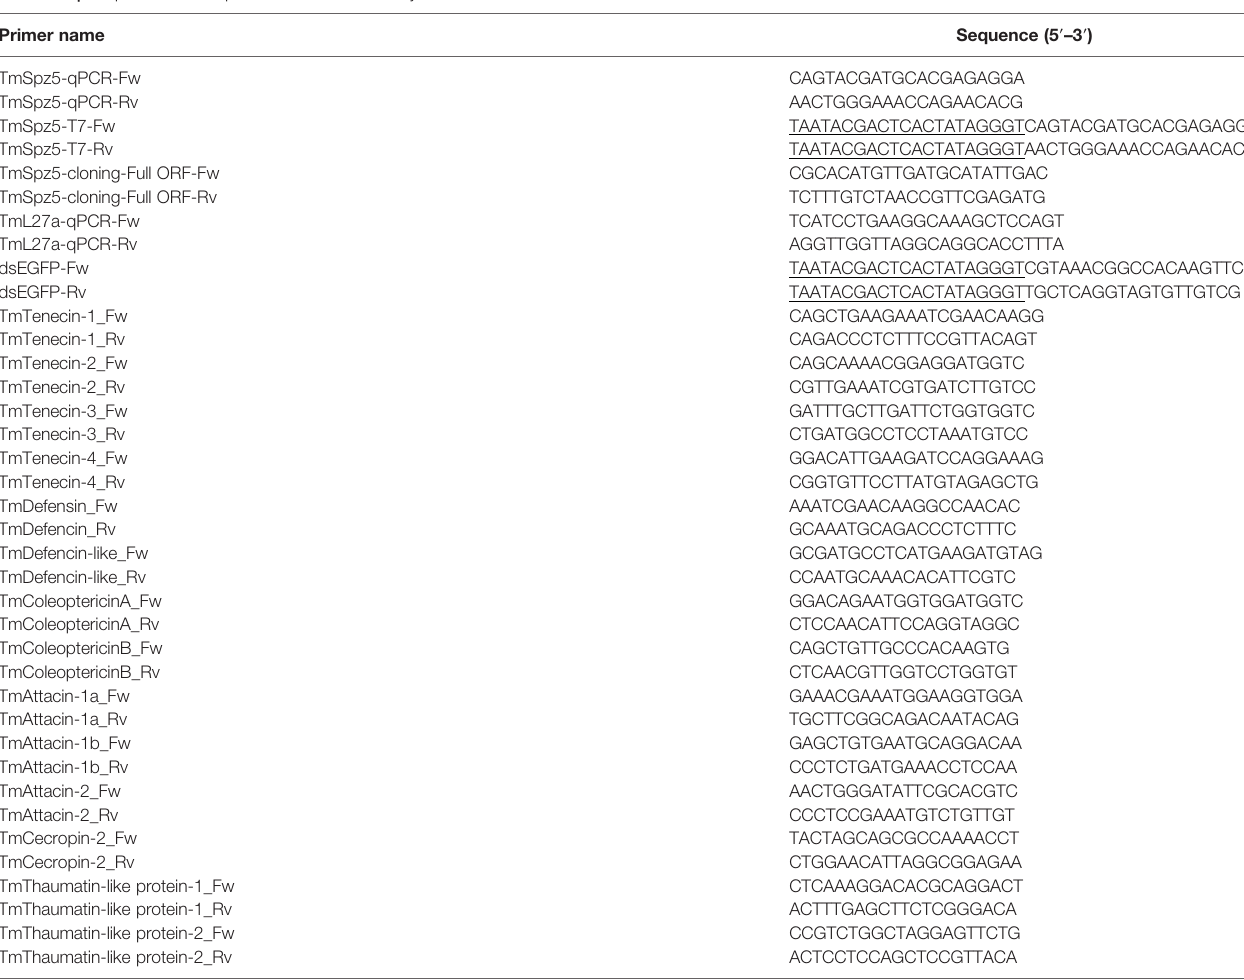
TABLE 1 | Sequences of the primers used in this